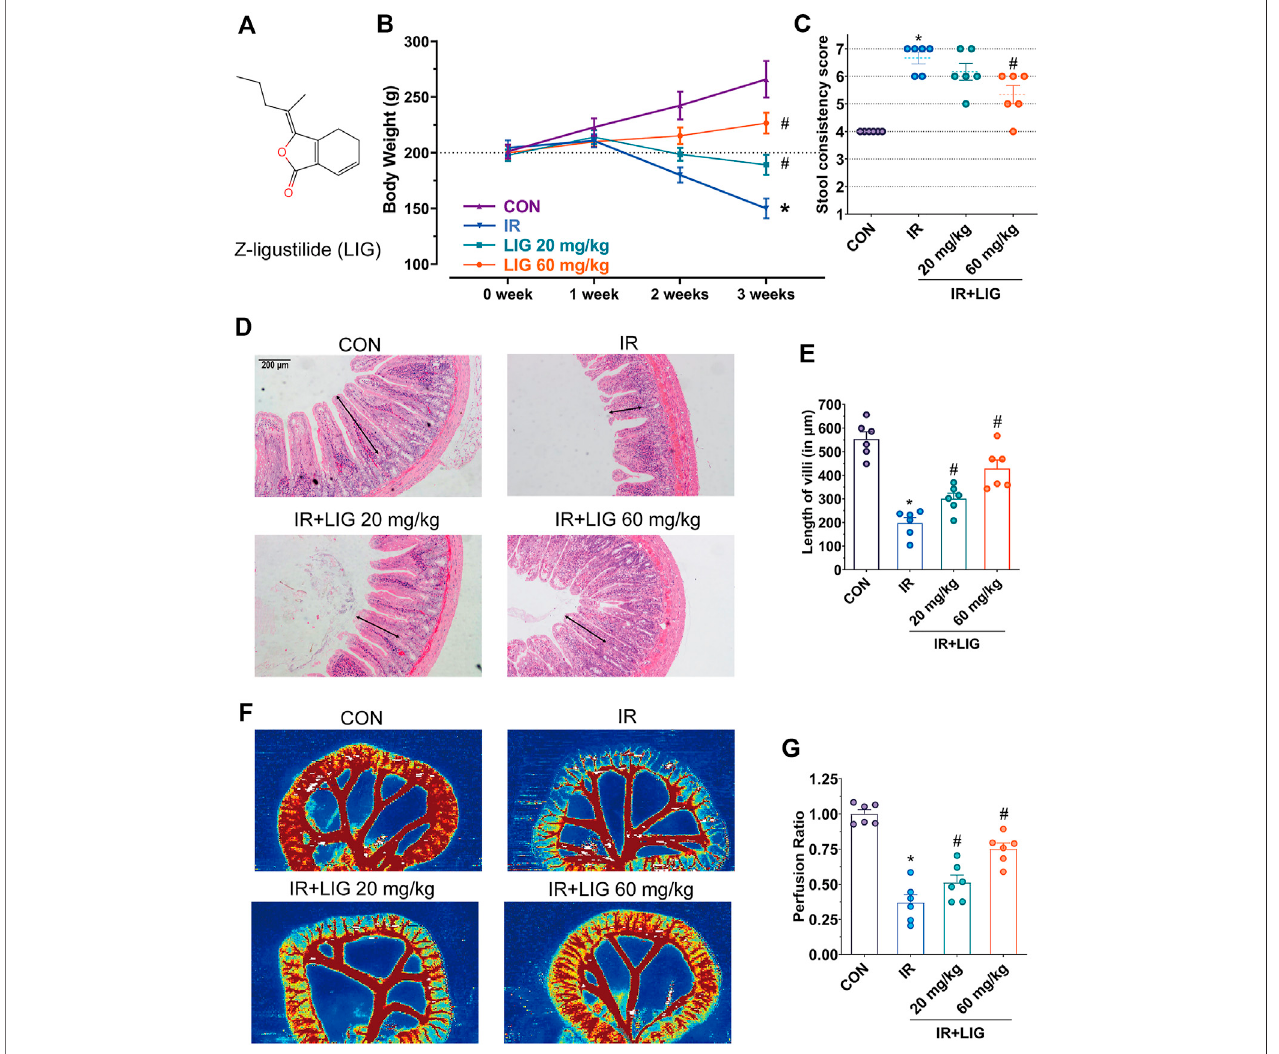
FIGURE1| EffectsofLIGonRE. (A) MolecularstructurediagramofLIG.Ratsreceived4 GyofIRandintraperitonealinjectionofLIGdaily(20or60 mg/kg).Rat (B) body weights and (C) stool consistency was recorded weekly. (D) Representative histopathological images showing the extent of jejunum damage after 3 weeks of IR withorwithoutLIG(20or60 mg/kg, perday)and (E) alterationsinvilluslength. (F) RepresentativelaserDopplerperfusion imagesofratsamplesafter3weeksofIRwith or without LIG and (G) laser Doppler perfusion ratios showing alterations in intestinal perfusion. CON, control group; IR, ionizing radiation; LIG, ligustilide. Data are the mean ± SEM; n (cid:1) 6. * p < 0.05, signi fi cantly different from the CON group; # p < 0.05, signi fi cantly different from the IR group.